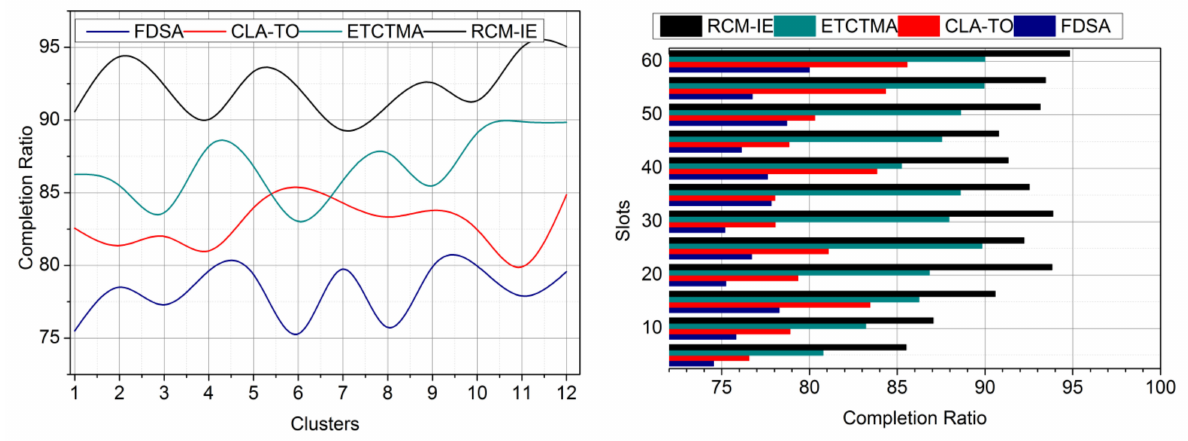
Figure 10. Completion ratio.